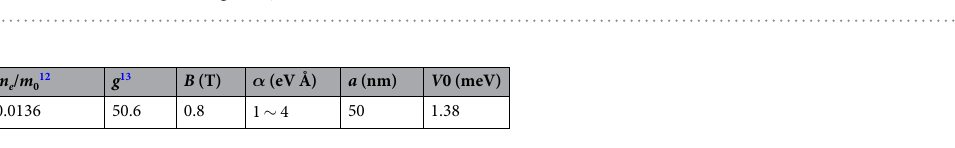
Figure 1. Schematically shown the confining potential of a nanowire quantum dot. ( a ) ISW with width a . ( b ) FSW with width a and height V 0 .